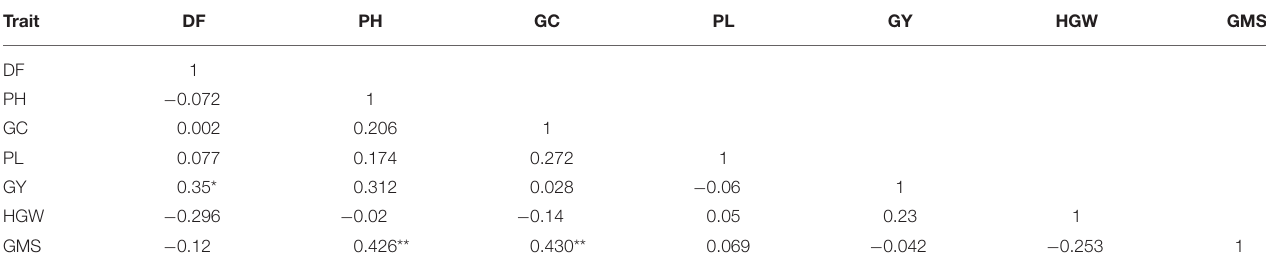
TABLE 7 | Coefficient of correlation between the studied traits across environments during 2018. Trait